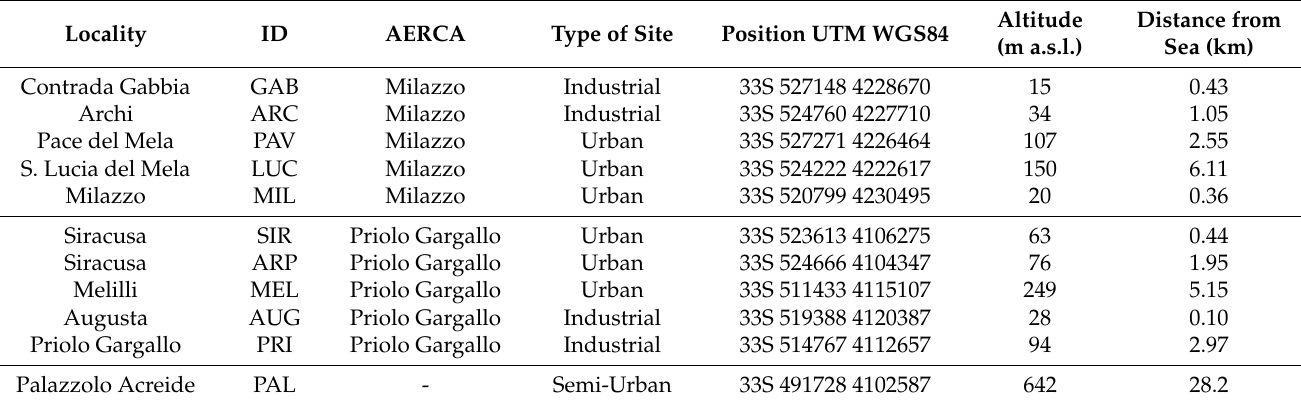
Table 1. The monitoring network and information of sampling